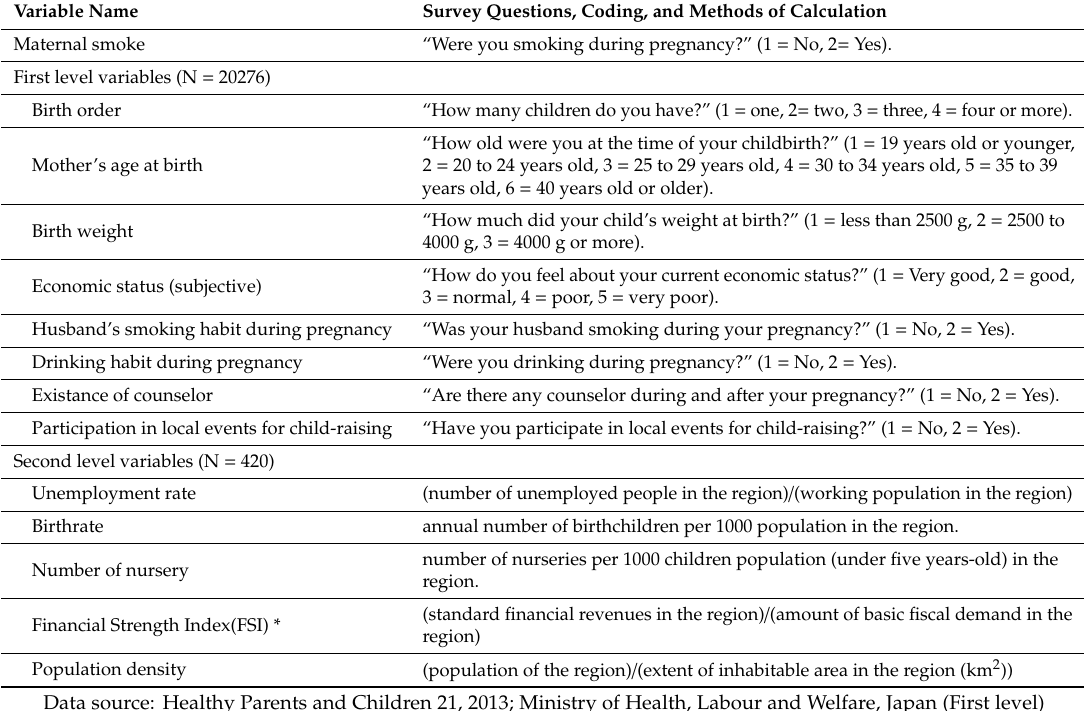
Table 1. Summary of Variable